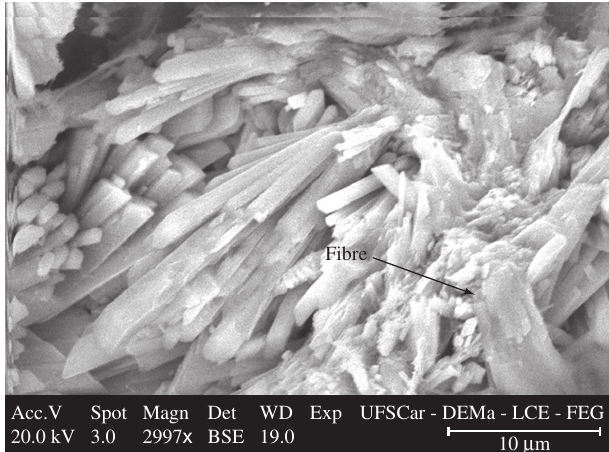
Acc.V Spot 20.0 kV 3.0 Figure 11. SEM image of fractured fibers.